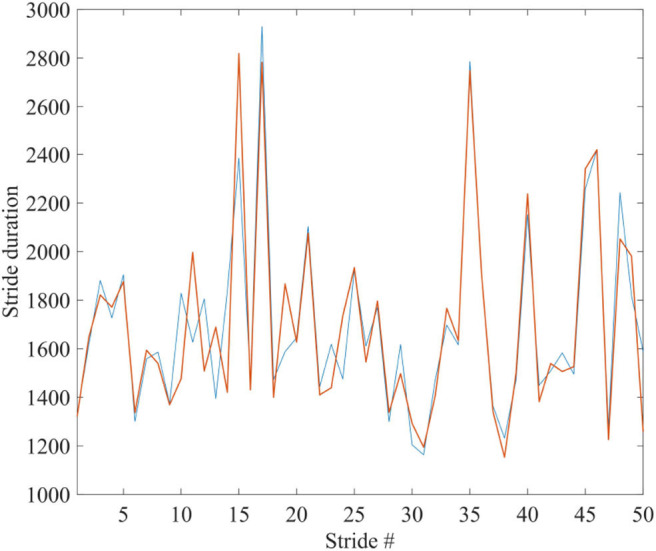
The blue and red curves show the duration times between the strides of x(t) of two systems, being connected back to back; corresponding to the spectra of Figure 4B: μ1 = 2.1, Ω1 = 2π/1, 000, μ2 = 2.9, Ω2 = 2π/100, r1 = r2 = 0.1. Ensemble size = 1.